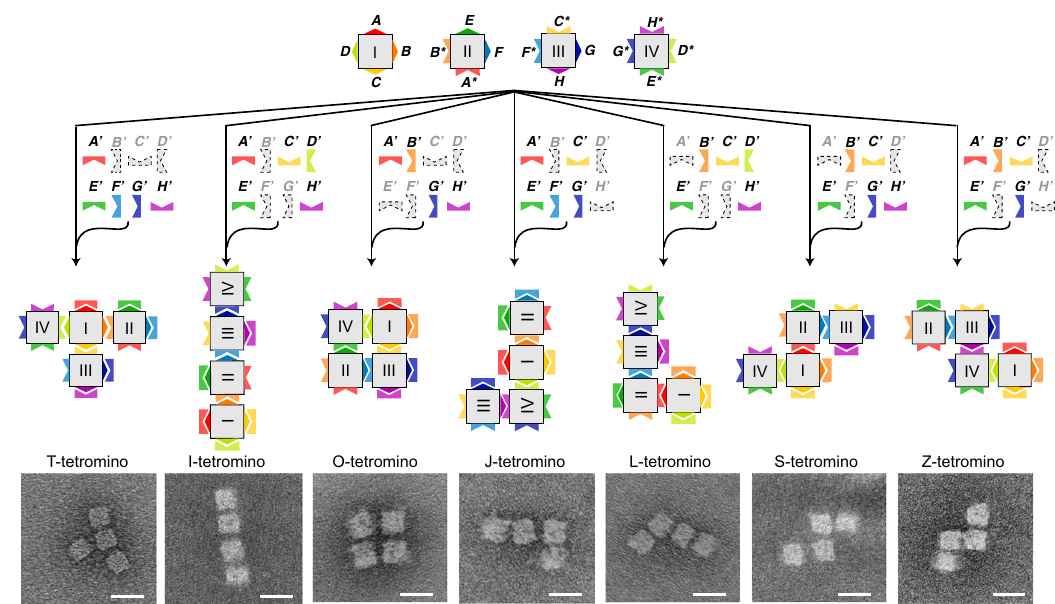
Fig. 5 Tetromino assembly based on a quadruple-unit system. There are four origami cuboid units (8H × 8H × 10T) in the system (I, II, III, and IV), and each unit with four sticky faces to bind with sticky faces of the matching units (convex and concave in a matching color depict a certain face pair). The sets of blockers in the presence (blockers in use highlighted in respective colors while blockers not in use faded in gray) react with the four basic units to result in the formation of one of the seven tetrominoes, T-, I-, O-, J-, L-, S-, and Z-tetrominoes. Scale bars: 25